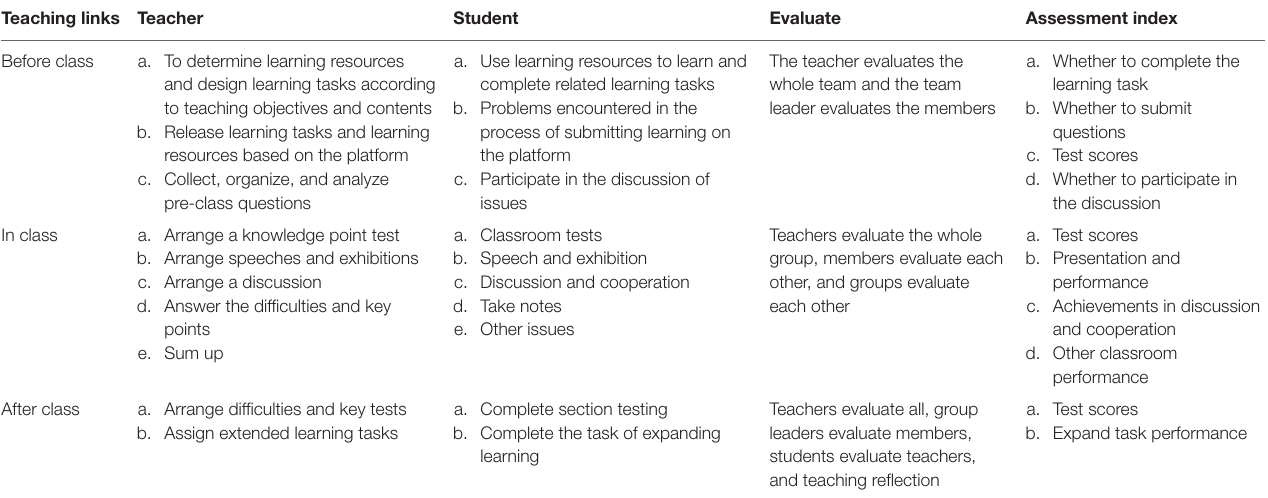
TABLE 1 | Teaching activities at each stage of the flipped classroom. Teaching links Teacher Student Evaluate Assessment